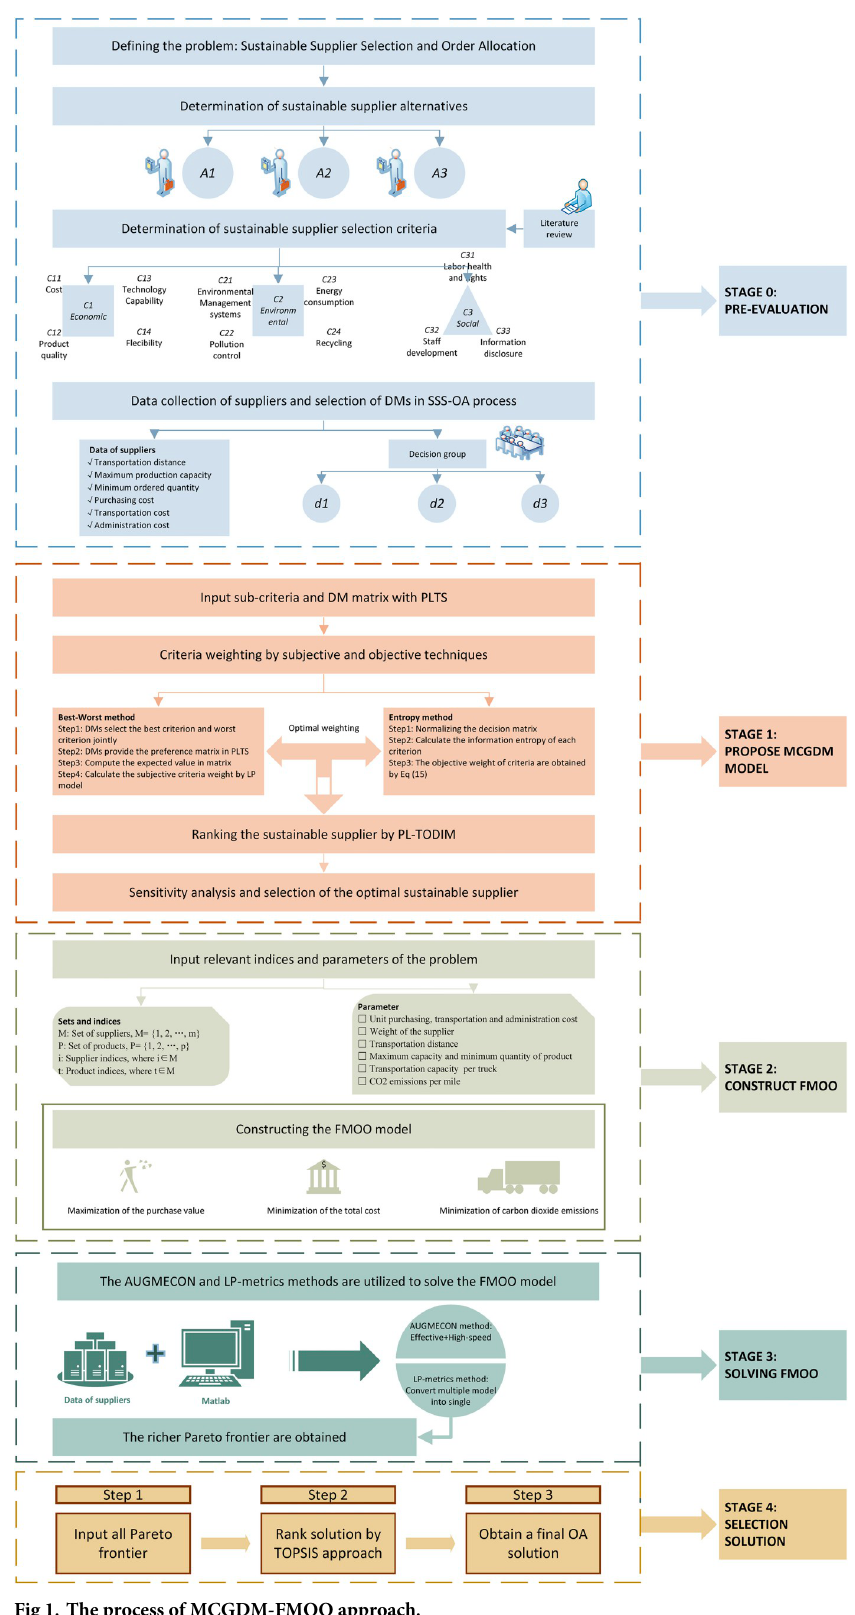
Fig 1. The process of MCGDM-FMOO